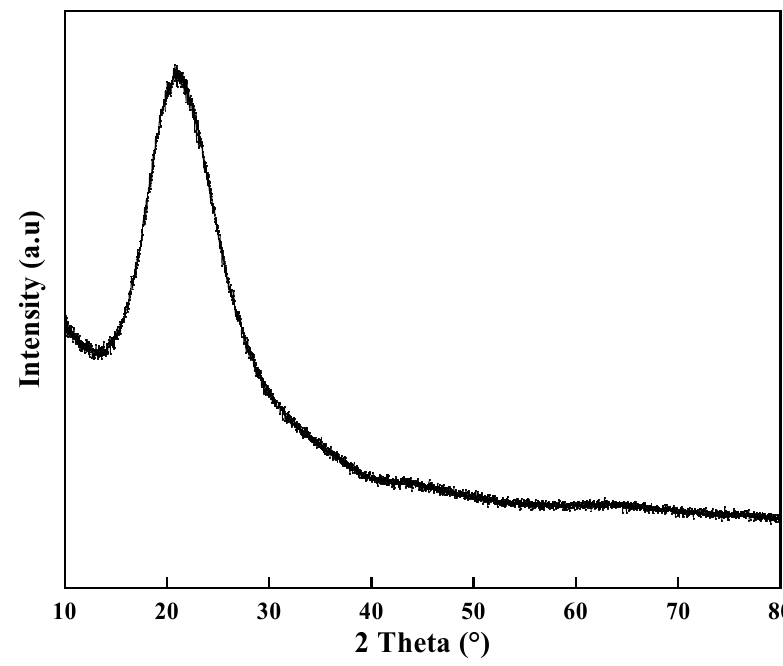
Figure 7. XRD spectrum of microcapsules.